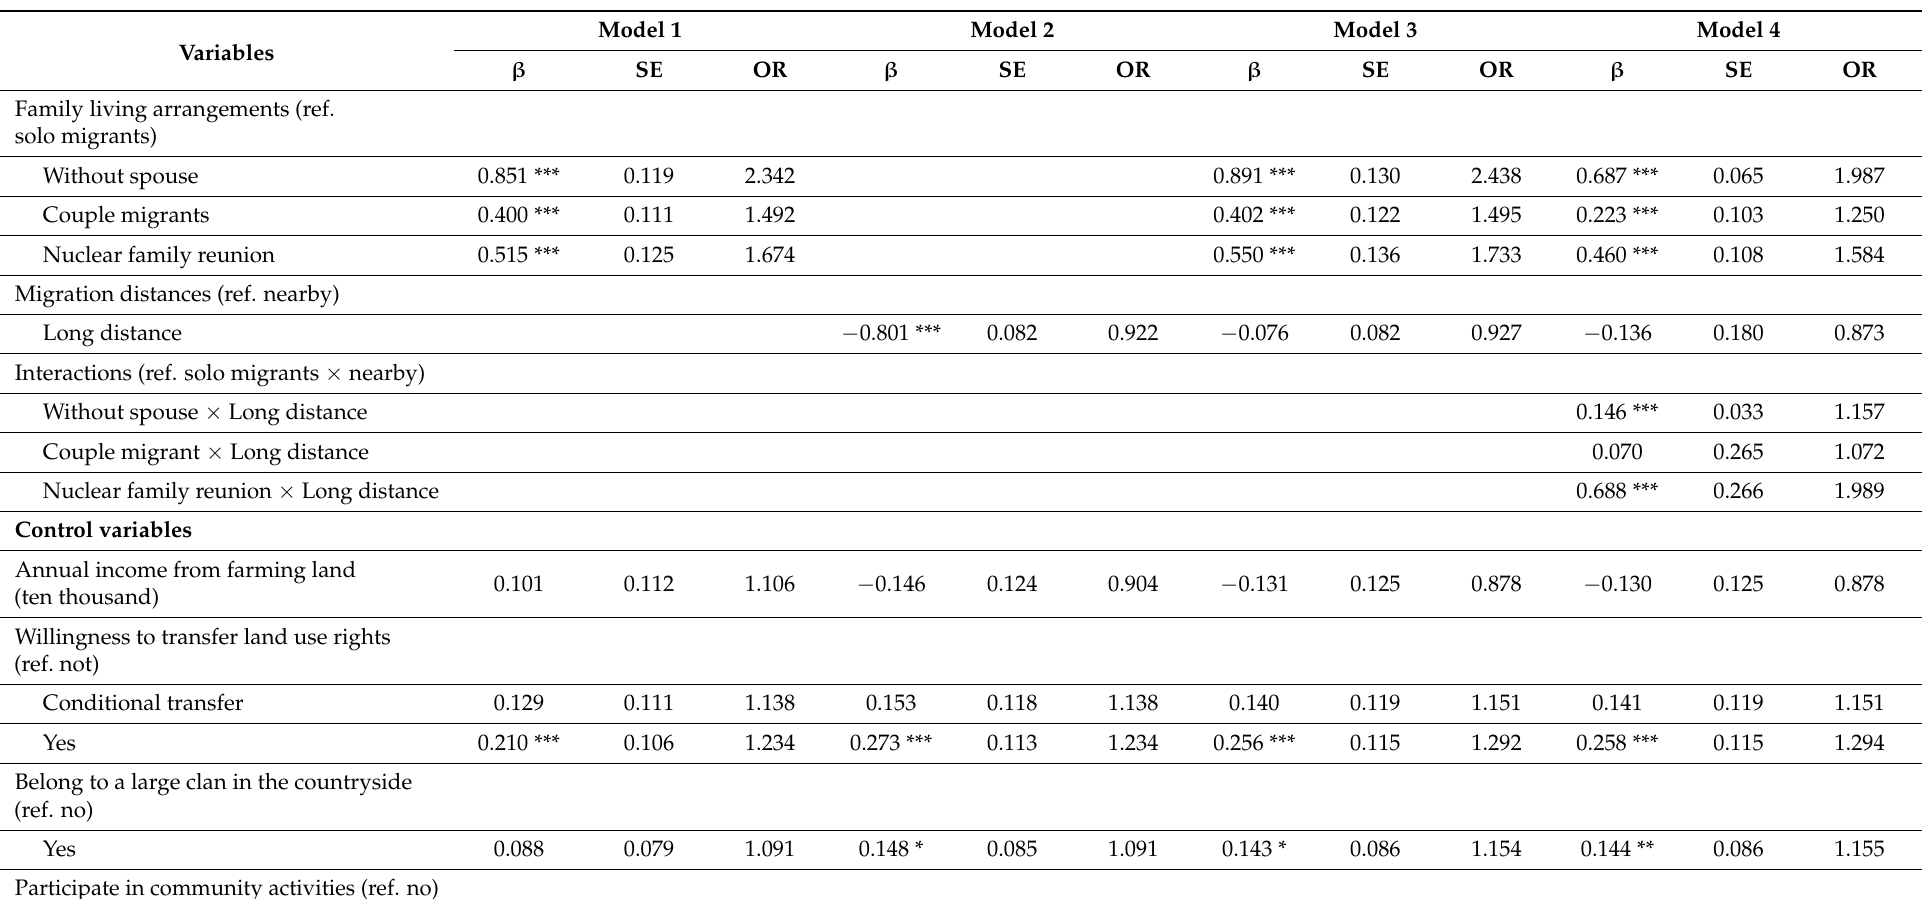
Table 3. Logit regression